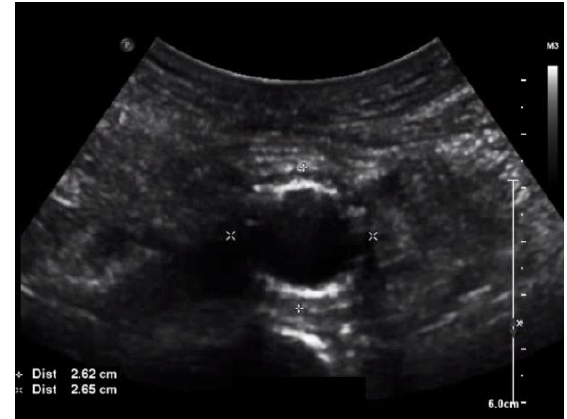
Figure 4. Duplex ultrasound at 6 months after endovascular repair of the mycotic aneurysm, demonstrating a stable sac that had decreased to a size of 2.65